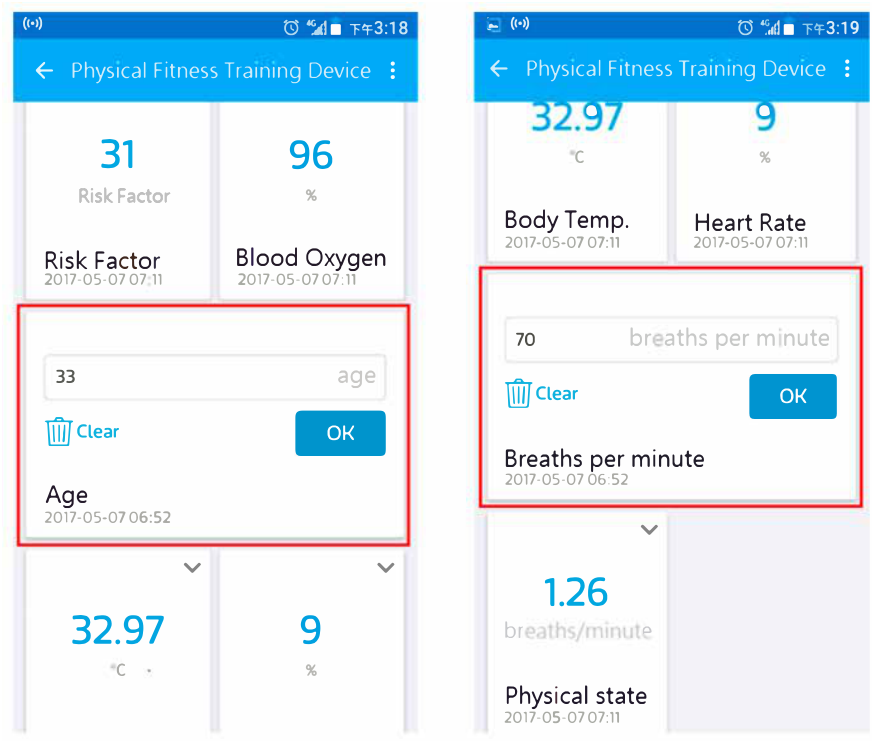
Figure 15. Heart rate and age of the subject. The respective risk factor, body temperature, heart rate, and SpO 2 sensing data were summarized, and the physical state of the subject was shown, as in Figure 16. It can be seen from the Figure 16d that exercise has no obvious effect on the change of blood oxygen value. The reason is that the change of blood oxygen value must be under high-intensity continuous exercise to have a chance to change drastically. Figure 17 shows a complete exercise cycle, and the changes in the first, middle, and late stages of exercise can be seen from the changes in physical fitness index.